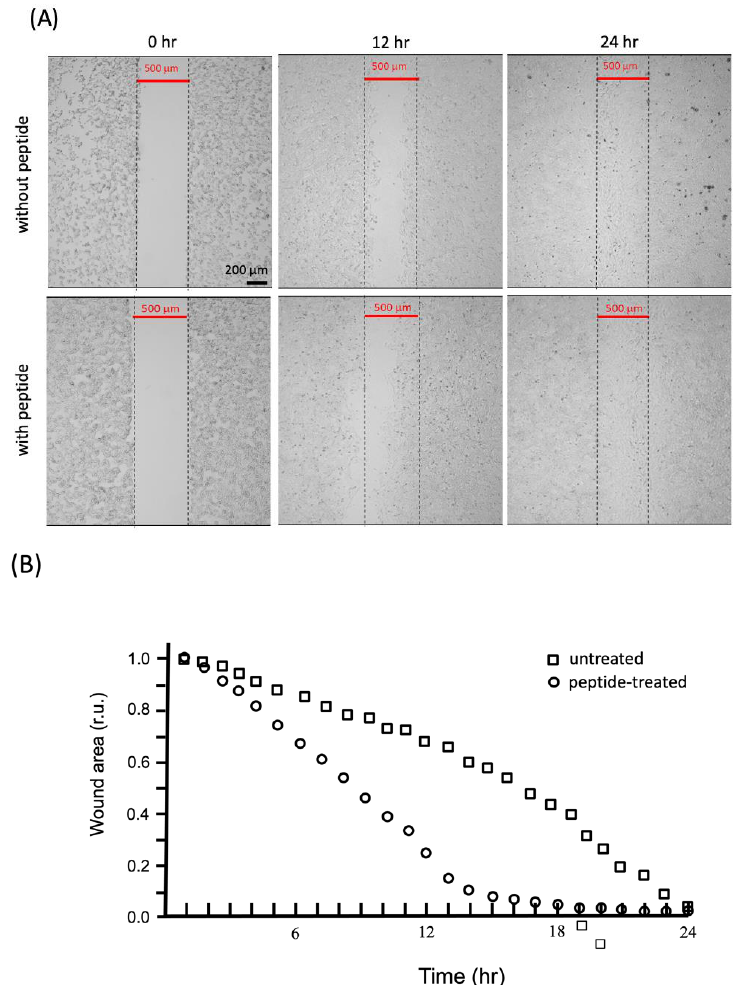
Figure A1. Analysis of NIH/3T3 fibroblastic cell migration by in vitro wound-healing assay. ( A ) Time-lapse microscopy images of wound closure of untreated (without peptide) and treated with peptide NIH/3T3 fibroblasts at 0, 12, and 24 h after culture insert removal. ( B ) Quantification of the wounded area during 24 h by untreated (square curve) and treated with peptide (circle curve) NIH/3T3 fibroblasts, presented in relative units (r.u.).